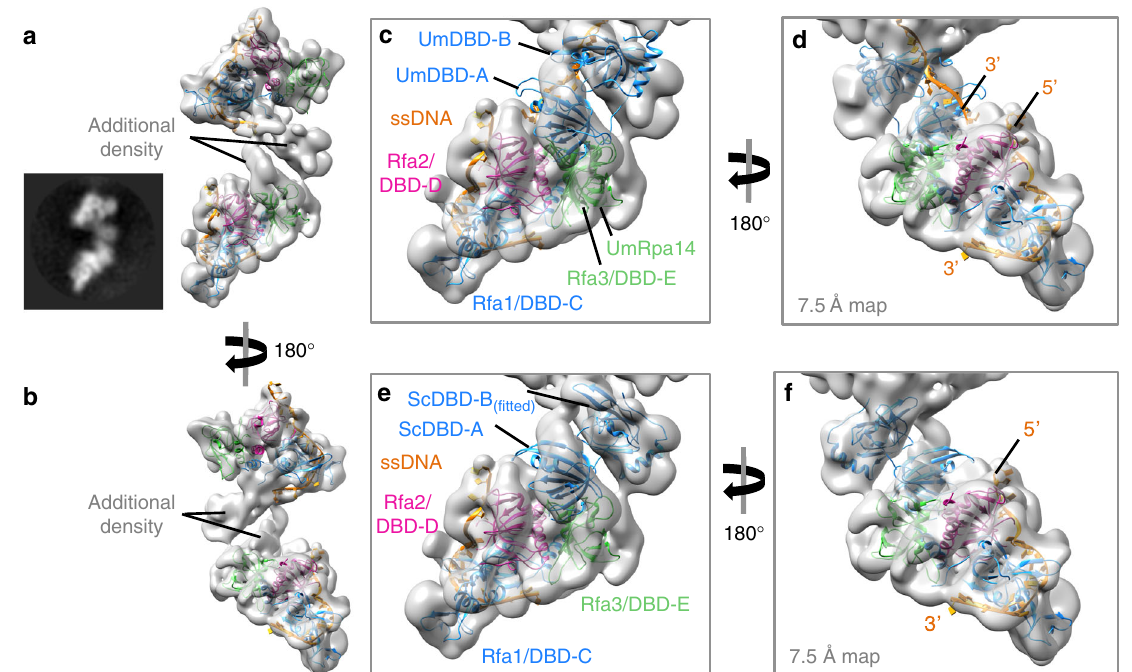
Fig. 3 CryoEM and structural analysis of an RPA dimer on ssDNA. a , b 3D reconstruction of yeast RPA dimer subclass at sub-nanometer resolution (7.5 Å by gold standard-FSC). The models fi tted in the 4.7 Å maps (colored as in Fig. 2) are fi tted into the density corresponding to the Tri-C. Additional density not described by the fi tted of the models. A 2D class average of a similar view is shown alongside ( a ). c , d The atomic co-ordinates Rpa14, DbdA/DbdB, and the associated ssDNA were excised from pdb: 4GOP and aligned by secondary structure onto DBD-E. The positions of DBD-A and DBD-B, relative to Rpa14 (aligned on DBD-E), are in similar positions to the additional density unaccounted for by either Tri-C. d The 5 ′ and 3 ′ ends of the ssDNA in each model are labeled to indicate that ssDNA could pass from DBD-A to the Tri-C. e , f DBD-A and DBD-B of the fungal structure from c , d are replaced with the yeast DBD-A NMR structure (pdb 1YNX) and a Phyre2-generated DBD-B homology model by superposition. DBD-B, which is slightly out of the density, is adjusted slightly by fi tted as a rigid body in Chimera. The density for DBD-A is slightly weaker than DBD-B, suggesting that even in this subclass there is some occupancy